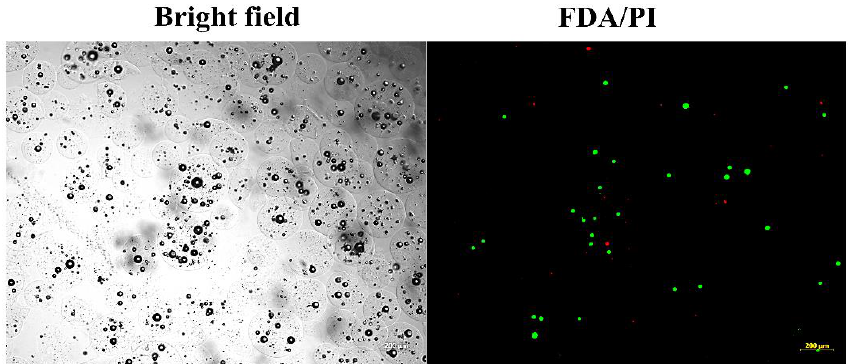
Figure 4. Microscope photographs of alginate beads containing hBM-MSCs observed in fluorescence and bright-field modes. hBM-MSCs were encapsulated in MVM alginate beads (2 × 10 6 cells/mL alginate) at agitation rates of 900 rpm and cultured for up to 4 weeks. For the fluorescence mode, cells were stained with FDA/PI. The scale bar is 200 µm.